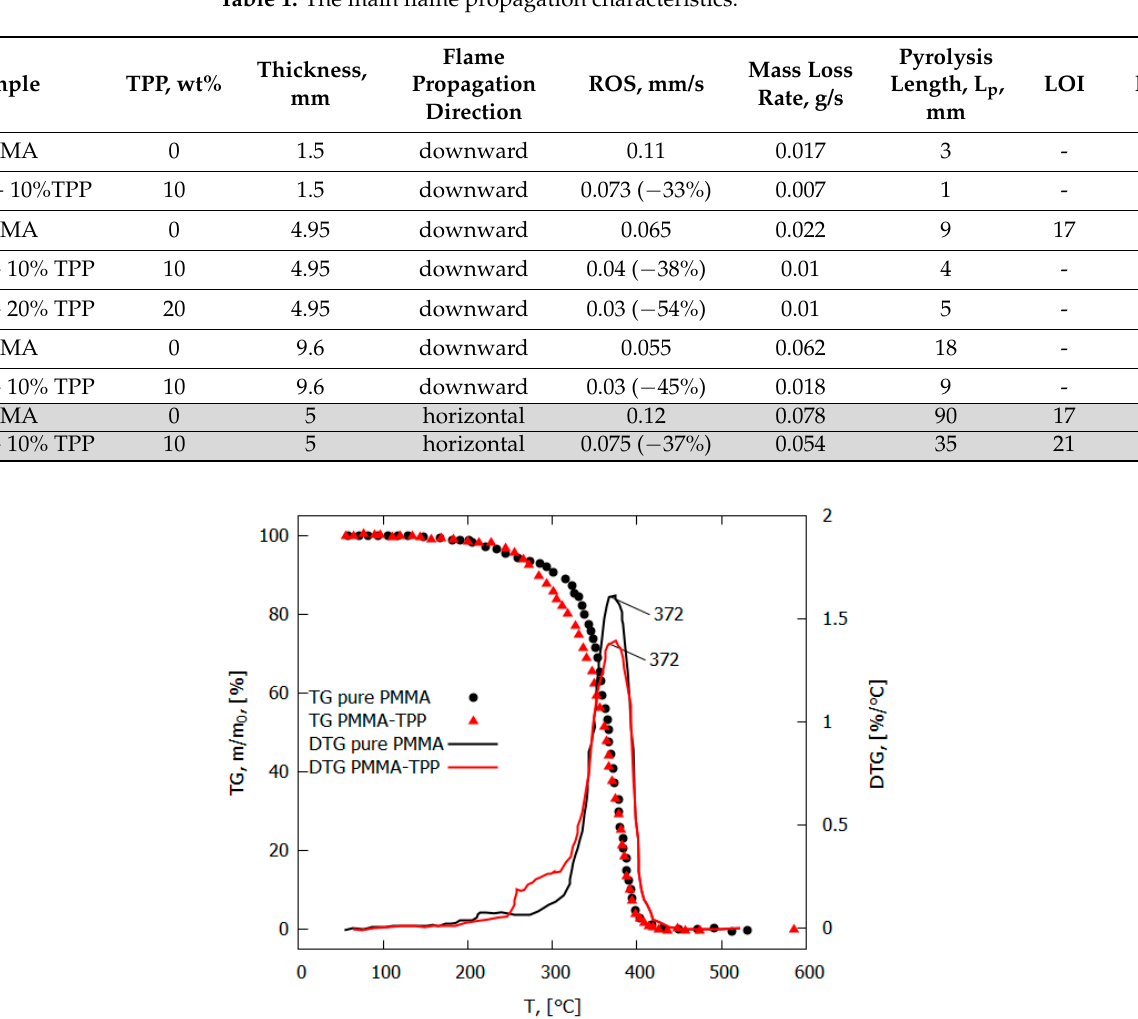
16 of 39 Table 1. The main flame propagation characteristics. Sample